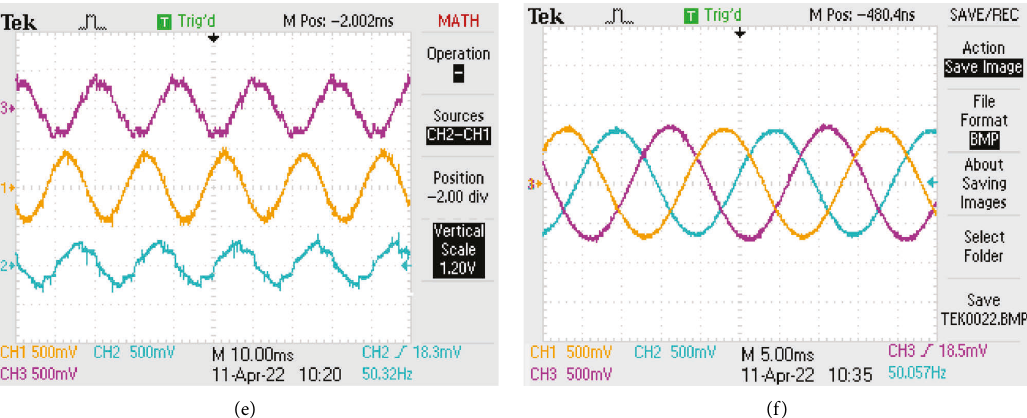
Figure 21: Experimental results of the proposed PV-SHAPF prototype model. (a) TPTL phase A output voltage. (b) TPTL phase B output voltage. (c) TPTL phase C output voltage. (d) Source current before compensation. (e) Source current, injected current, and load current. (f) Source current after